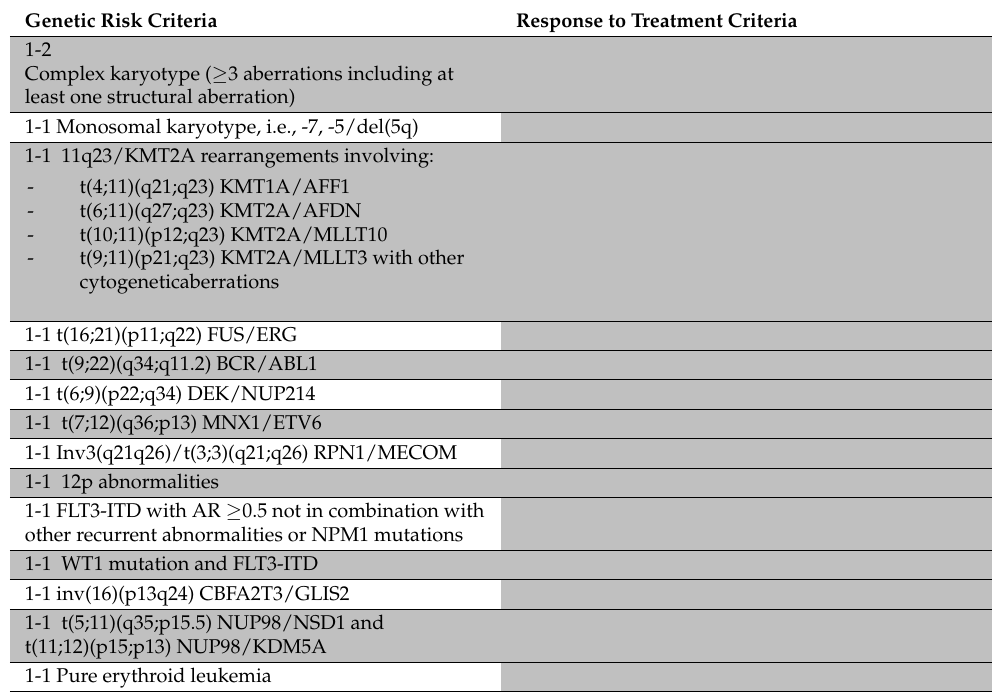
Table 1. Characteristics of pediatric high-risk